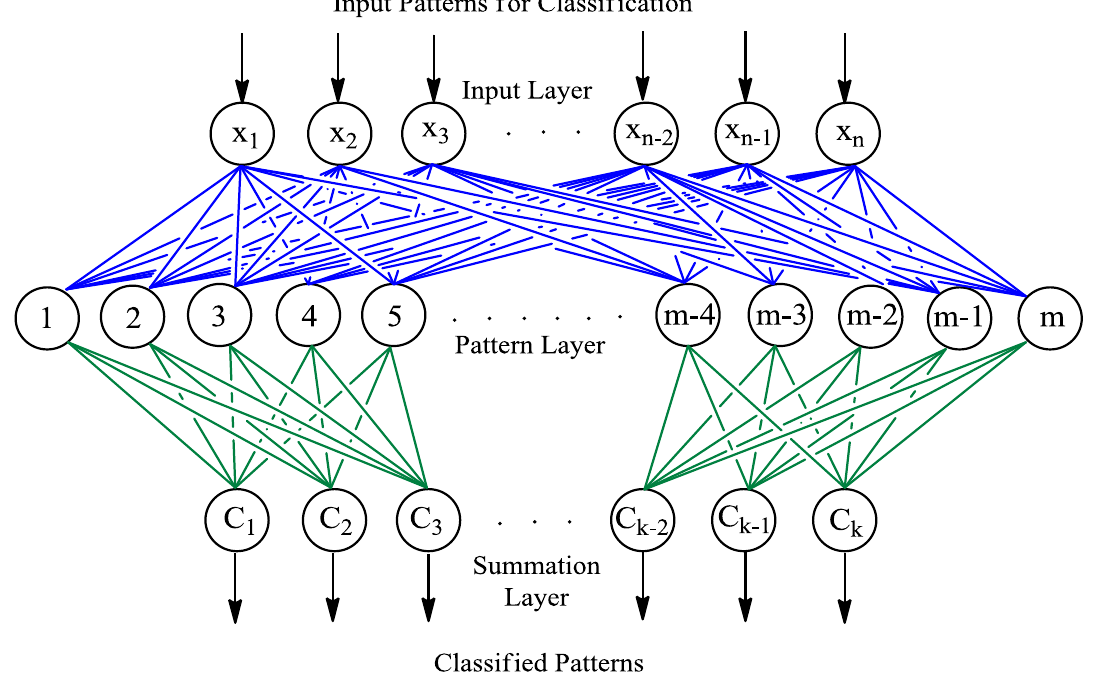
Figure 9. Probabilistic neural network (PNN) general architecture.